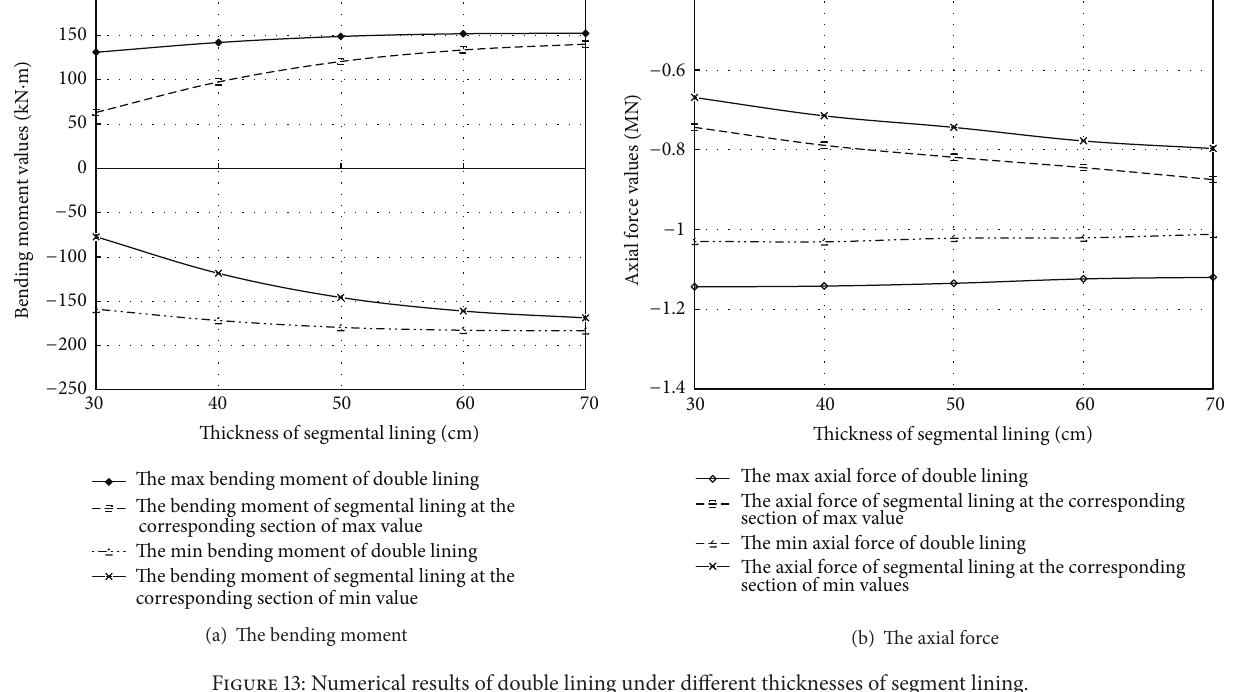
Figure 13: Numerical results of double lining under different thicknesses of segment lining. Table 6: The bending moments extreme values under different thicknesses of segment